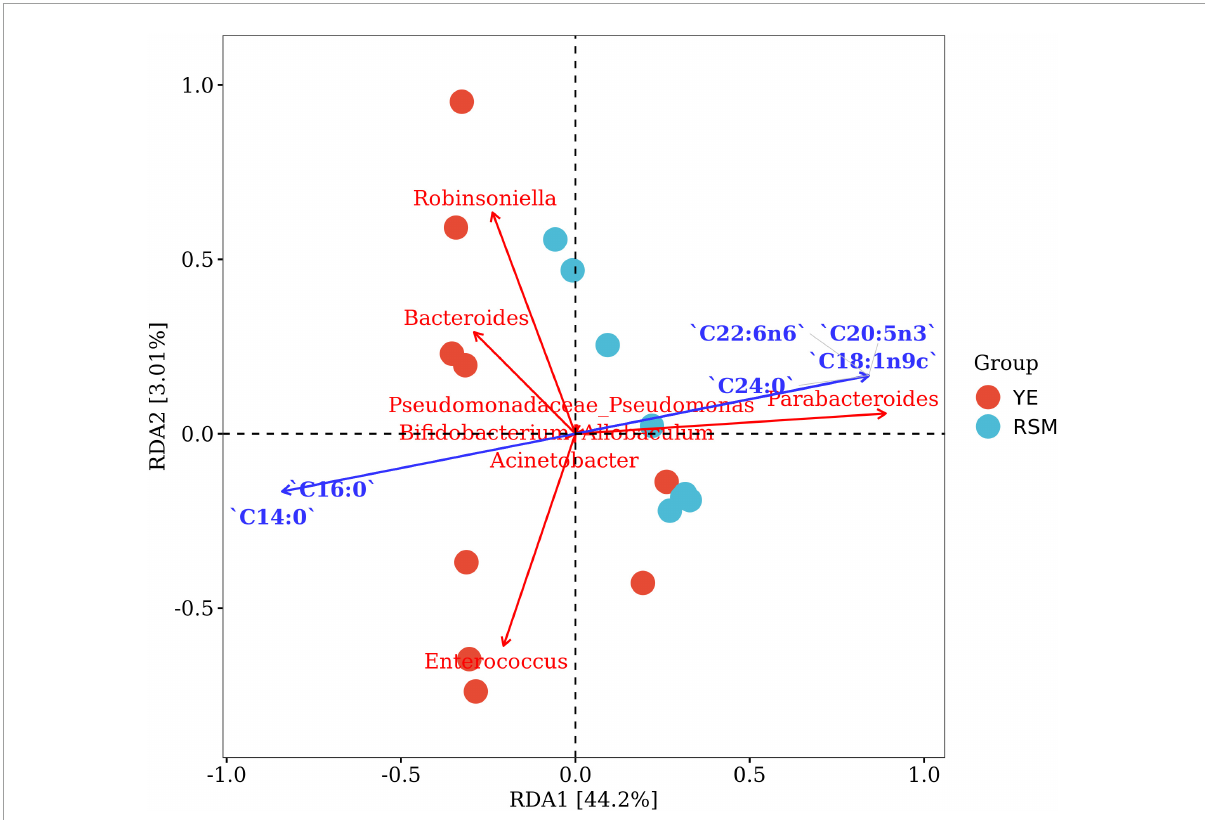
FIGURE8 Redundancy analysis (RDA) showed the correlation between changed gut microbiota and fatty acid composition of two algal oil. The red dots and blue dots represent the YE group and RSM group, respectively. The blue arrow indicates a significant correlation with the bacteria ( P <